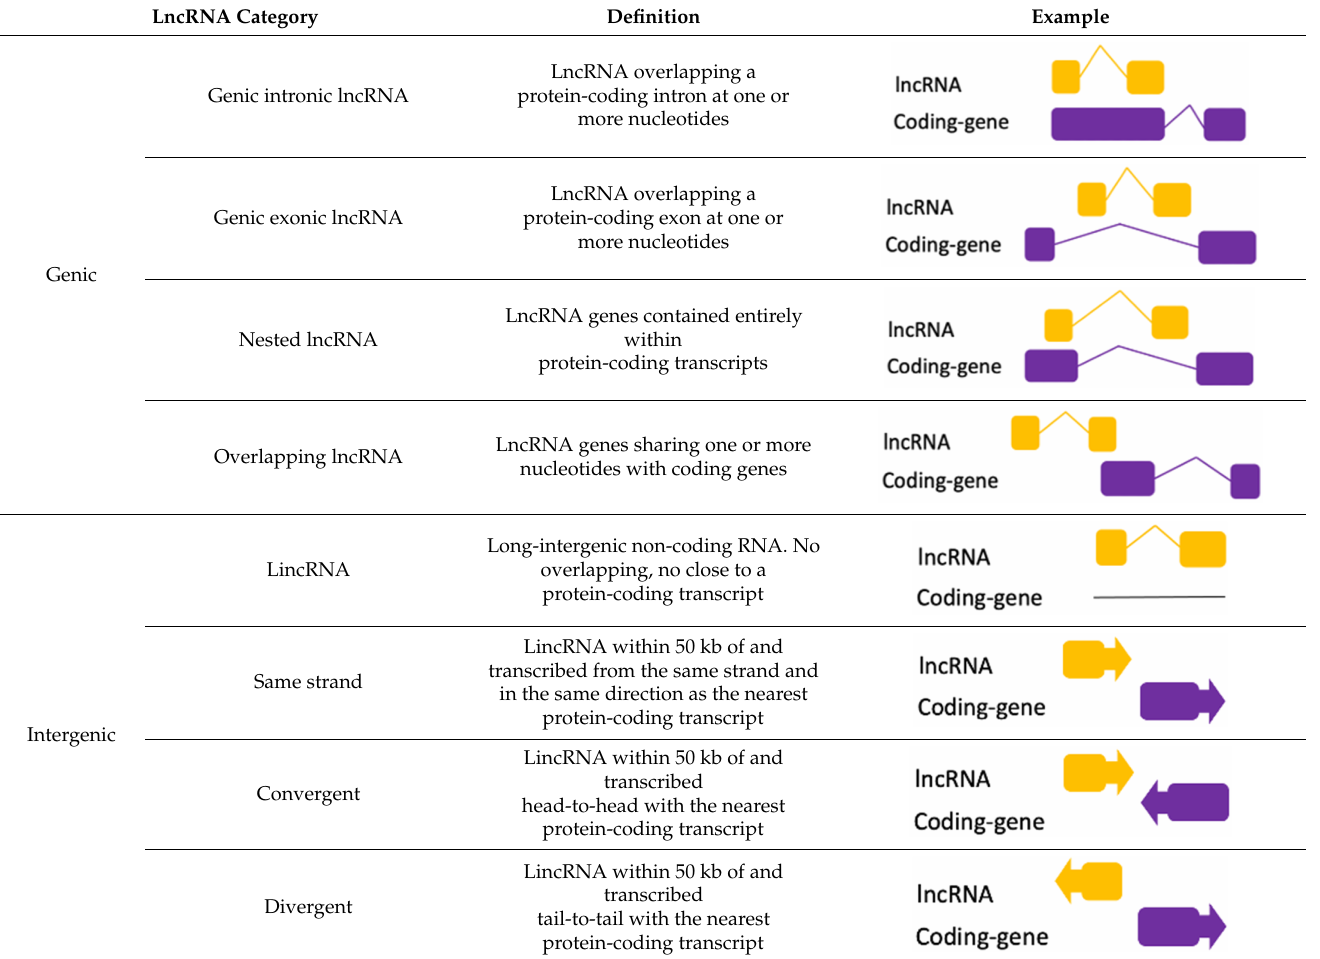
Table 2. LncRNAs classification attending to genomic